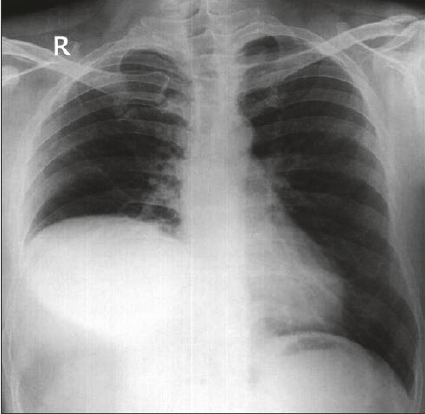
Figure 1: Chest X-ray with right hemidiaphragm paralysis.